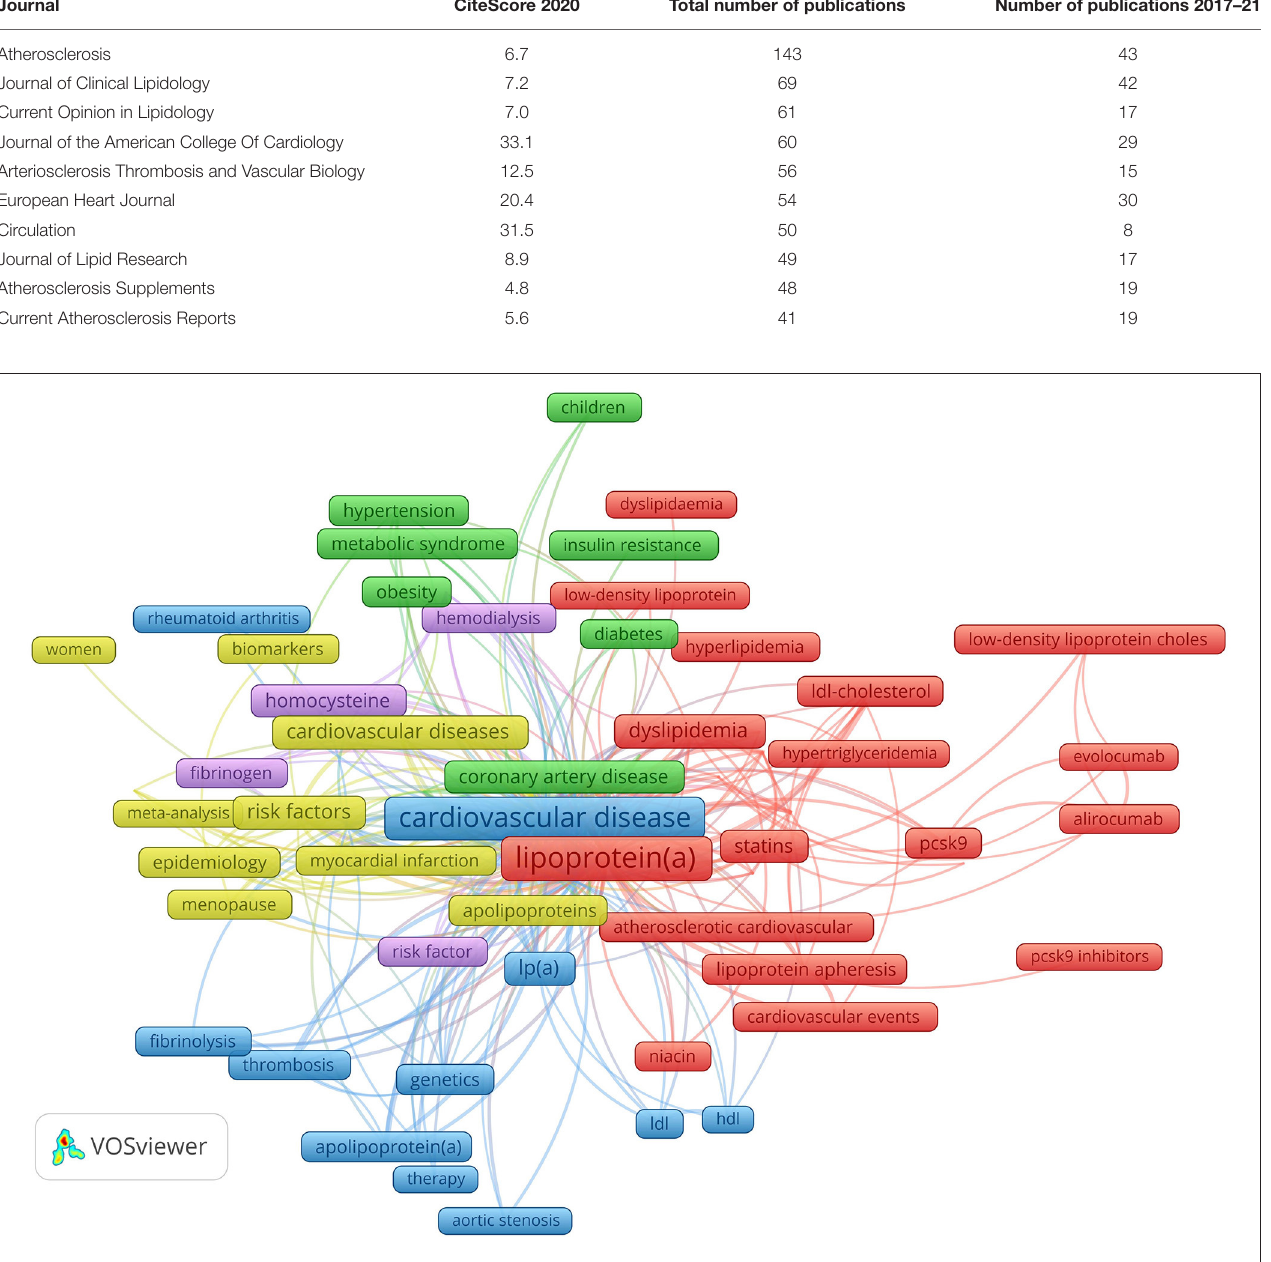
FIGURE 4 | Author keywords (with 20 or more occurrences) cluster landscape. Author keywords cluster landscape revealed five research themes: Lp(a) and inflammation (violet), Lp(a) cardiovascular diseases (blue), Lp(a) in women (yellow), prevention and treatment of coronary artery disease in diabetic patients (green), lipid abnormalities and treatment